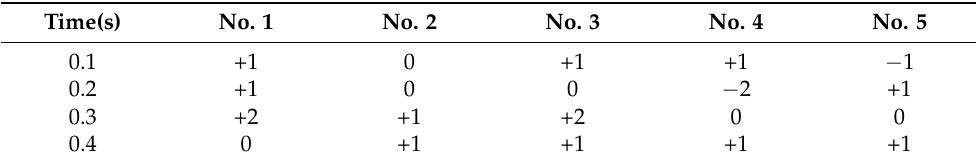
Table 2. X-direction coordinate changes for the dendrites.